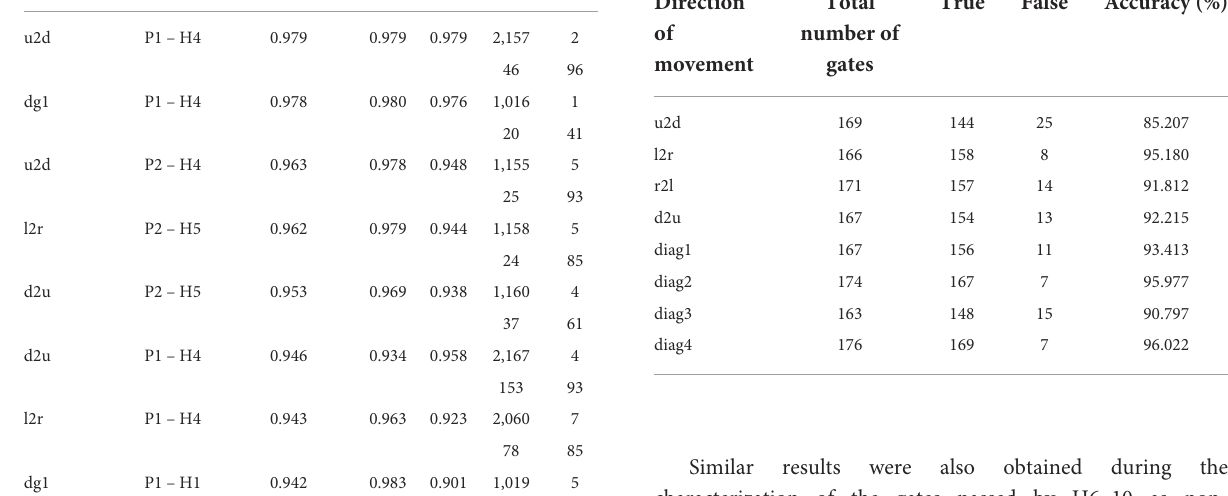
TABLE 3 Implementation of the classifiers on the external control dataset of